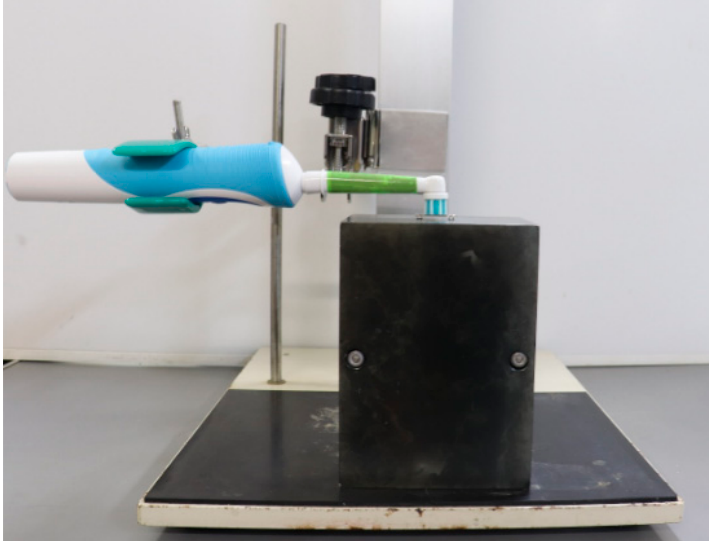
Figure 1. Toothbrush setup. Brackets were fixed to a metal block with adhesive. The coated wire was ligated to the brackets using an elastic module. The electric toothbrush was fixed to the experimental stand.